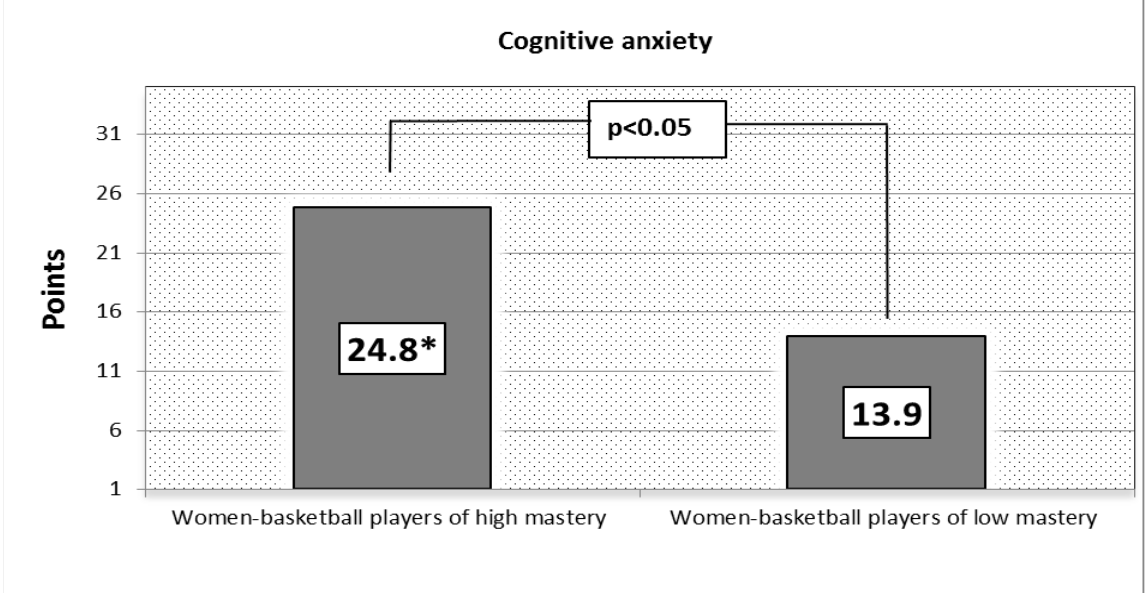
Fig. 1. Distribution of cognitive anxiety indexes of women-basketball players of different mastery (in points) Note: * – marking of the statistically reliable difference